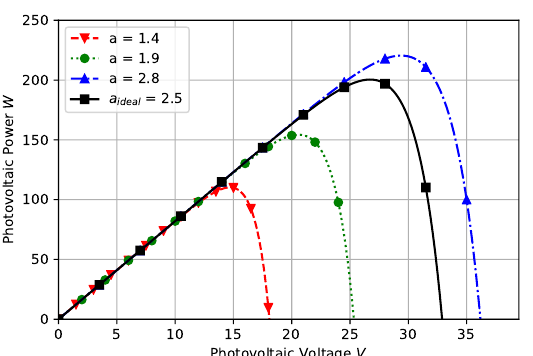
Figure 3. Behavior of the output power as a function of the voltage for different values of a using the ideal photovoltaic